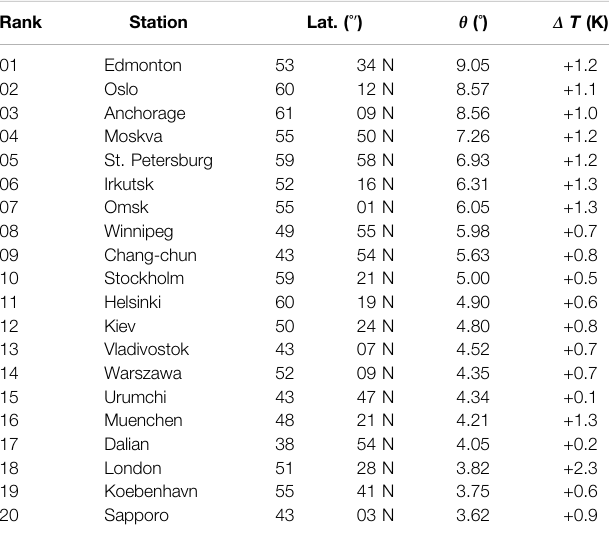
TABLE 1B | Top-twenty World stations in the intersecting angle of the monthly temperatures from Period II (from 1951 to 1980) to Period III (from 1981 to